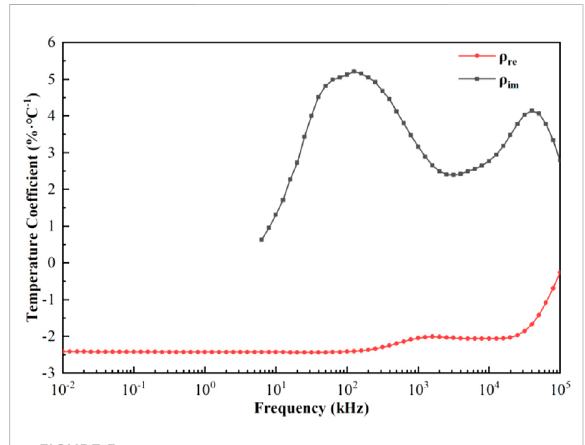
FIGURE 5 Temperature coef fi cients of the real and imaginary parts of resistivity as a function of